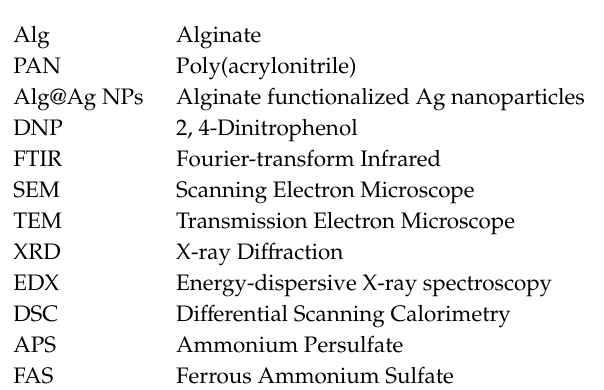
Table S1: Range of the variable parameters; Table S2: Design table including the number of experiments with respect to the obtained experimental and predicted data; Figure S1: Elemental Mapping for C, O, N, and Ag elements constituting PAN-g-Alg@Ag NC; Figure S2: (a) UV–Vis plot; and (b) degradation rate of DNP vs. concentration of NaCl to observe the e ff ect of electrolyte concentration (NaCl) on the photocatalytic degradation of DNP under direct solar irradiation and optimized reaction conditions; Figure S3: Mineralization of DNP during the photodegradation with PAN-g-Alg@Ag NC using direct solar irradiation: ( a ) total organic carbon (TOC); and ( b ) chemical oxygen demand (COD); Figure S4: Regeneration and reusability graphs for PAN-g-Alg@Ag NC and Alg@Ag NPs towards DNP